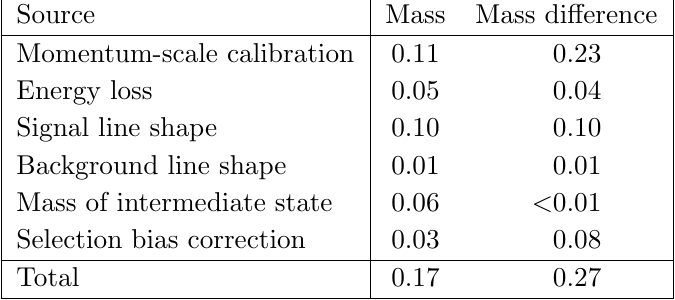
Table 5. Breakdown of systematic uncertainties (in MeV =c 2 ) in the combination of the B + and the mass di(cid:11)erence (cid:1) M . The total uncertainty is the sum in quadrature of the uncertainty of di(cid:11)erent sources.